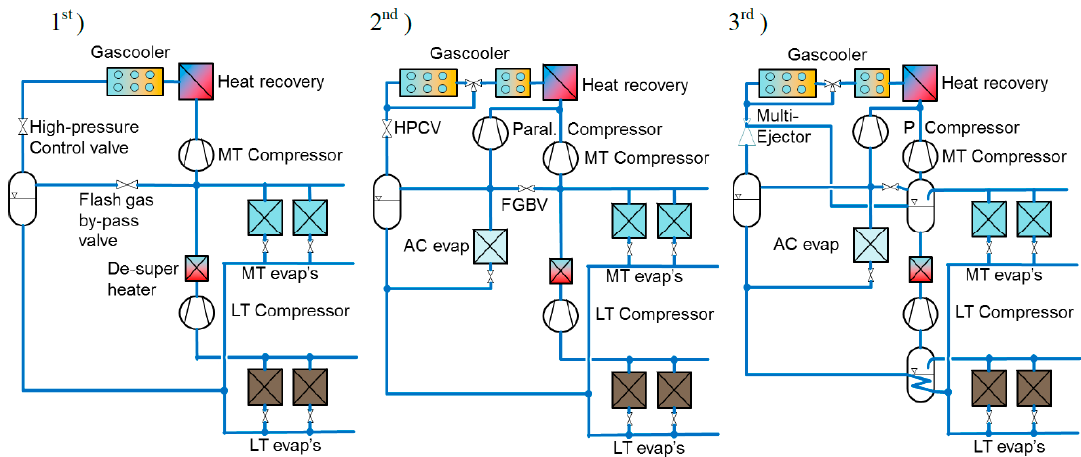
Figure 3. Schematic of the 1st, 2nd and 3rd generation of “CO 2 only” booster supermarket refrigeration system layouts [20].